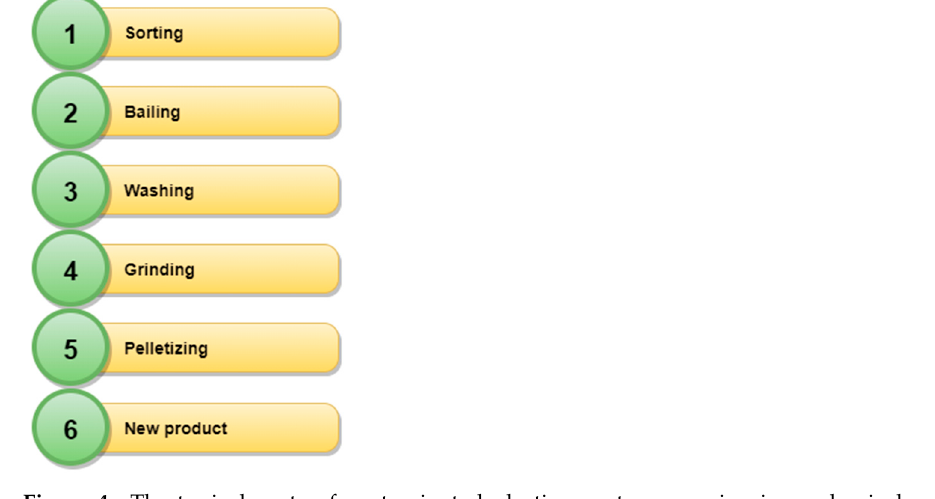
Figure 4. The typical route of contaminated plastics waste processing in mechanical recycling ac- cording to [64,65]. according to